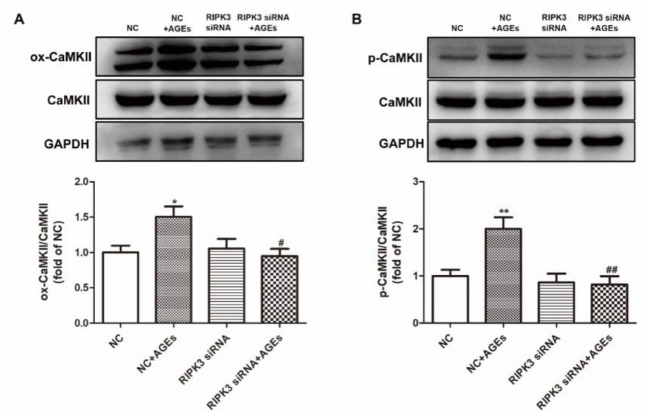
Figure 9. Downregulation of RIPK3 inhibited CaMKII activation in cardiomyocytes. Cardiomyocytes were transfected with RIPK3 siRNA for 4 h followed by 200 µ g/mL AGEs stimulation for 24 h. ( A ) The expression of ox-CaMKII and CaMKII was detected by Western blot in cardiomyocytes. GAPDH was used as a loading control. ( B ) The expression of p-CaMKII and CaMKII was detected by Western blot in cardiomyocytes. GAPDH was used as a loading control. Plots represent the mean ± SEM; n = 6. Statistical significance: * p < 0.05, ** p < 0.01 compared with NC; # p < 0.05, ## p < 0.01 compared with